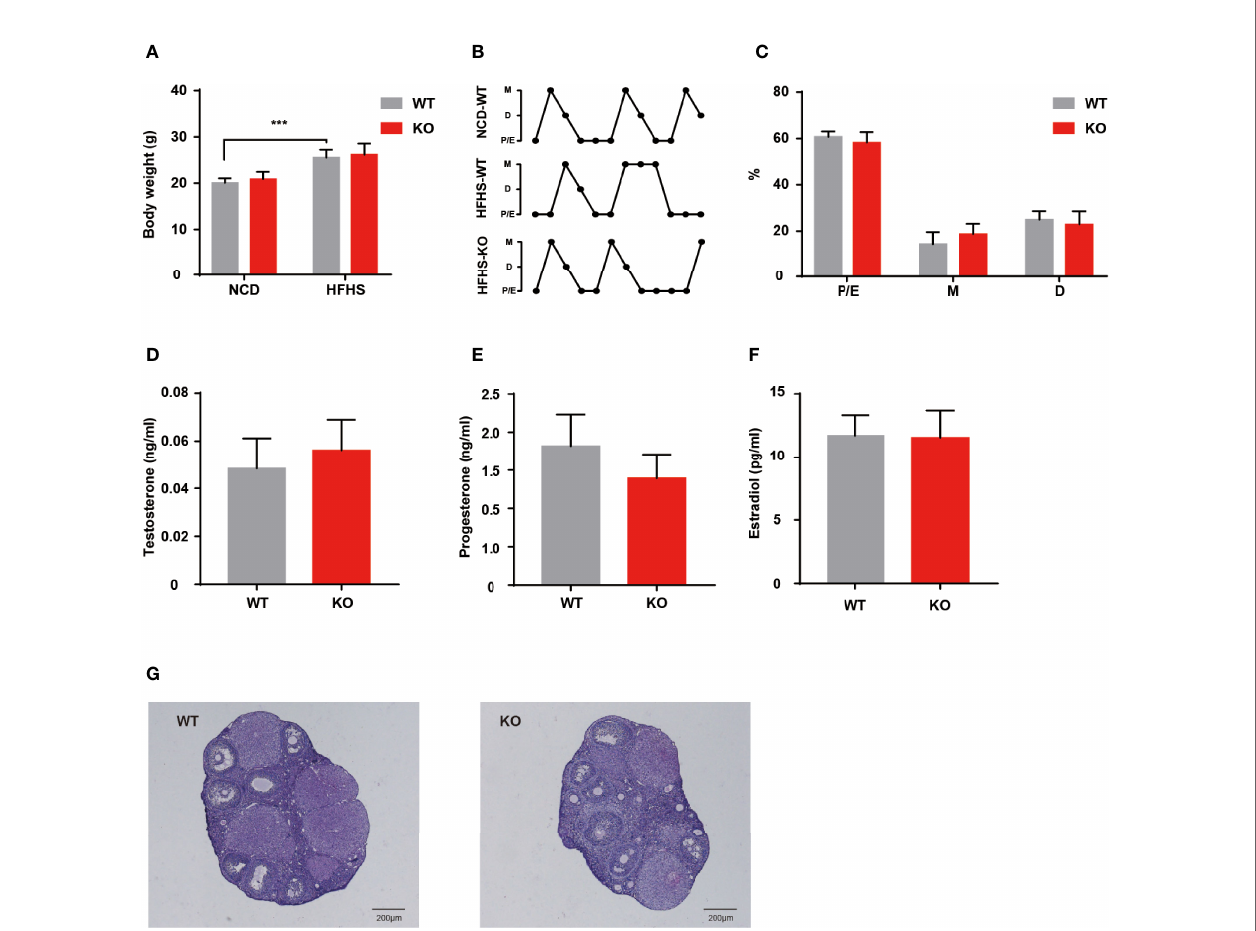
FIGURE 4 | HFHS could not induce reproductive dysfunctions in KO mice. (A) Body weights were measured for WT and KO mice with normal chow diet or HFHS diet (n = 6-10). (B, C) Estrous cycle pro fi le of WT and KO mice with ten weeks HFHS-fed. WT mice with the normal chow diet were selected as control groups (n = 7-8). (D – F) . Serum levels of testosterone, progesterone, and estradiol of HFHS-fed mice (n = 7-8). (G) HE stained histological sections of ovaries, scale bar=200 m M. ***P <